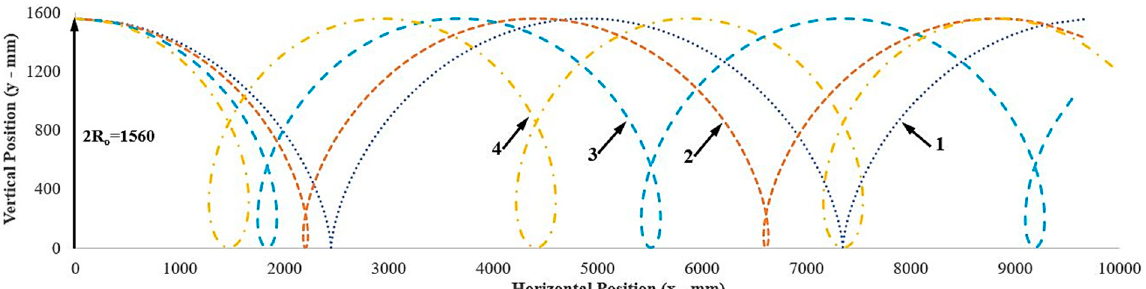
Figure 6. Motion trail or trajectories of point M at different travel reduction rates, Corves 1, 2, 3 and 4 represent travel reduction rate of 0.0, 0.1, 0.25 and 0.4 respectively.